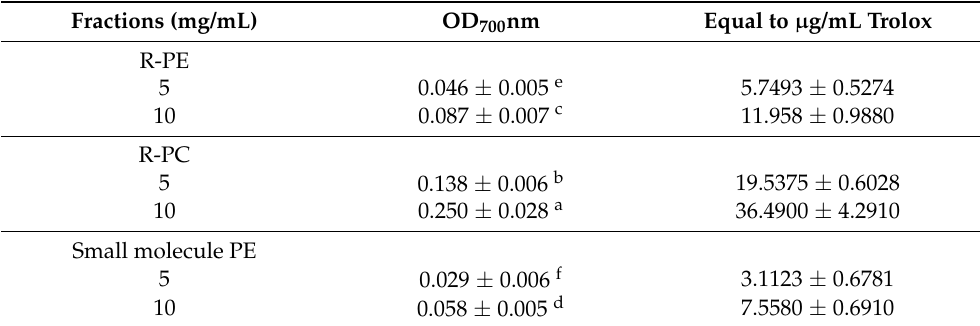
Table 5. Reducing power of phycobiliprotein extracts from Porphyra.